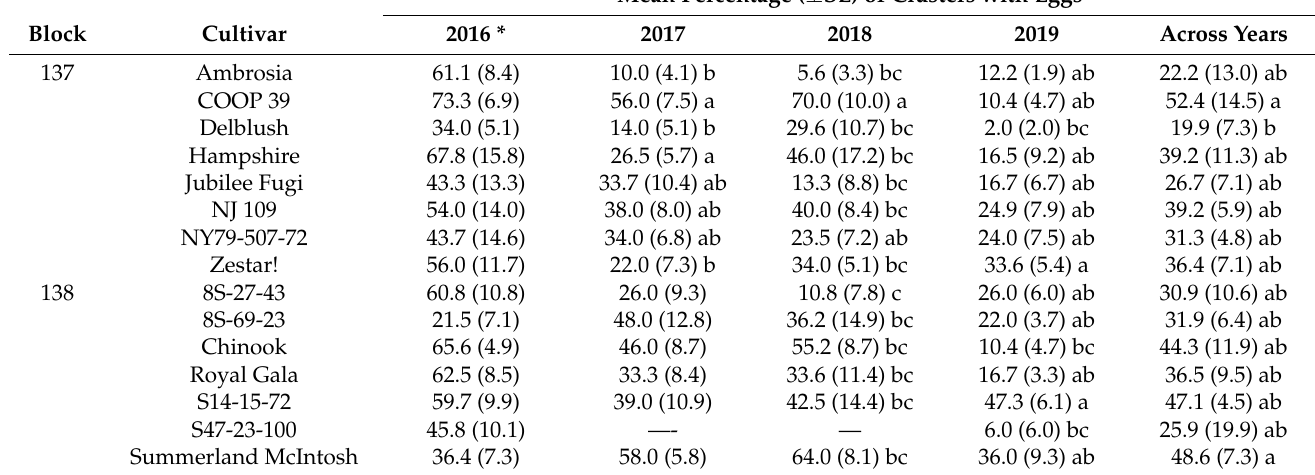
Table 2. Mean percentage ( ± SE) of clusters with Hoplocampa testudinea eggs from 15 cultivars located in 2 blocks at Kentville Research and Development Centre from 2016–2019. Means within column and block with different letters significantly different ( p <